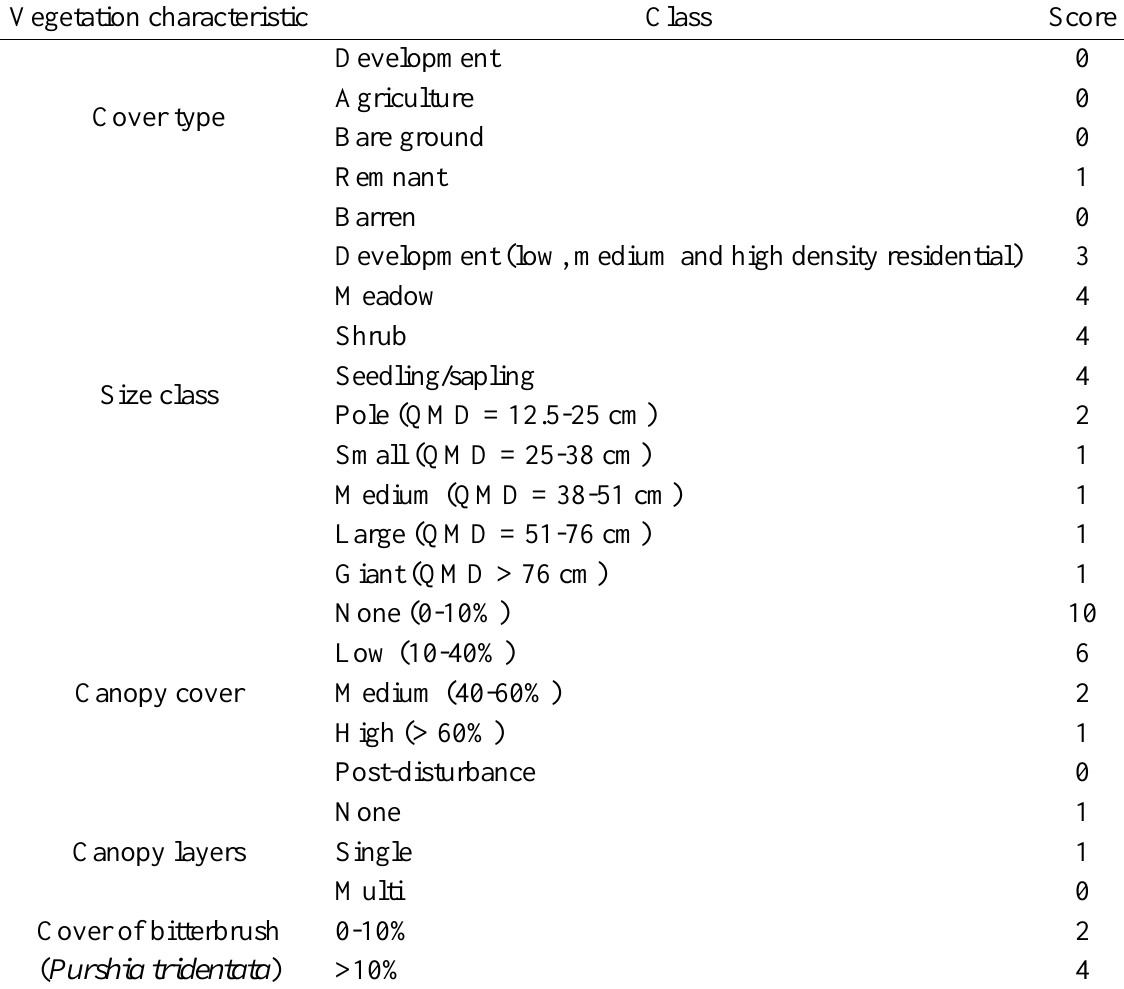
Table A 10.2. Habitat model for mule deer: scoring system for foraging habitat. (Note: QMD is quadratic mean diameter.)